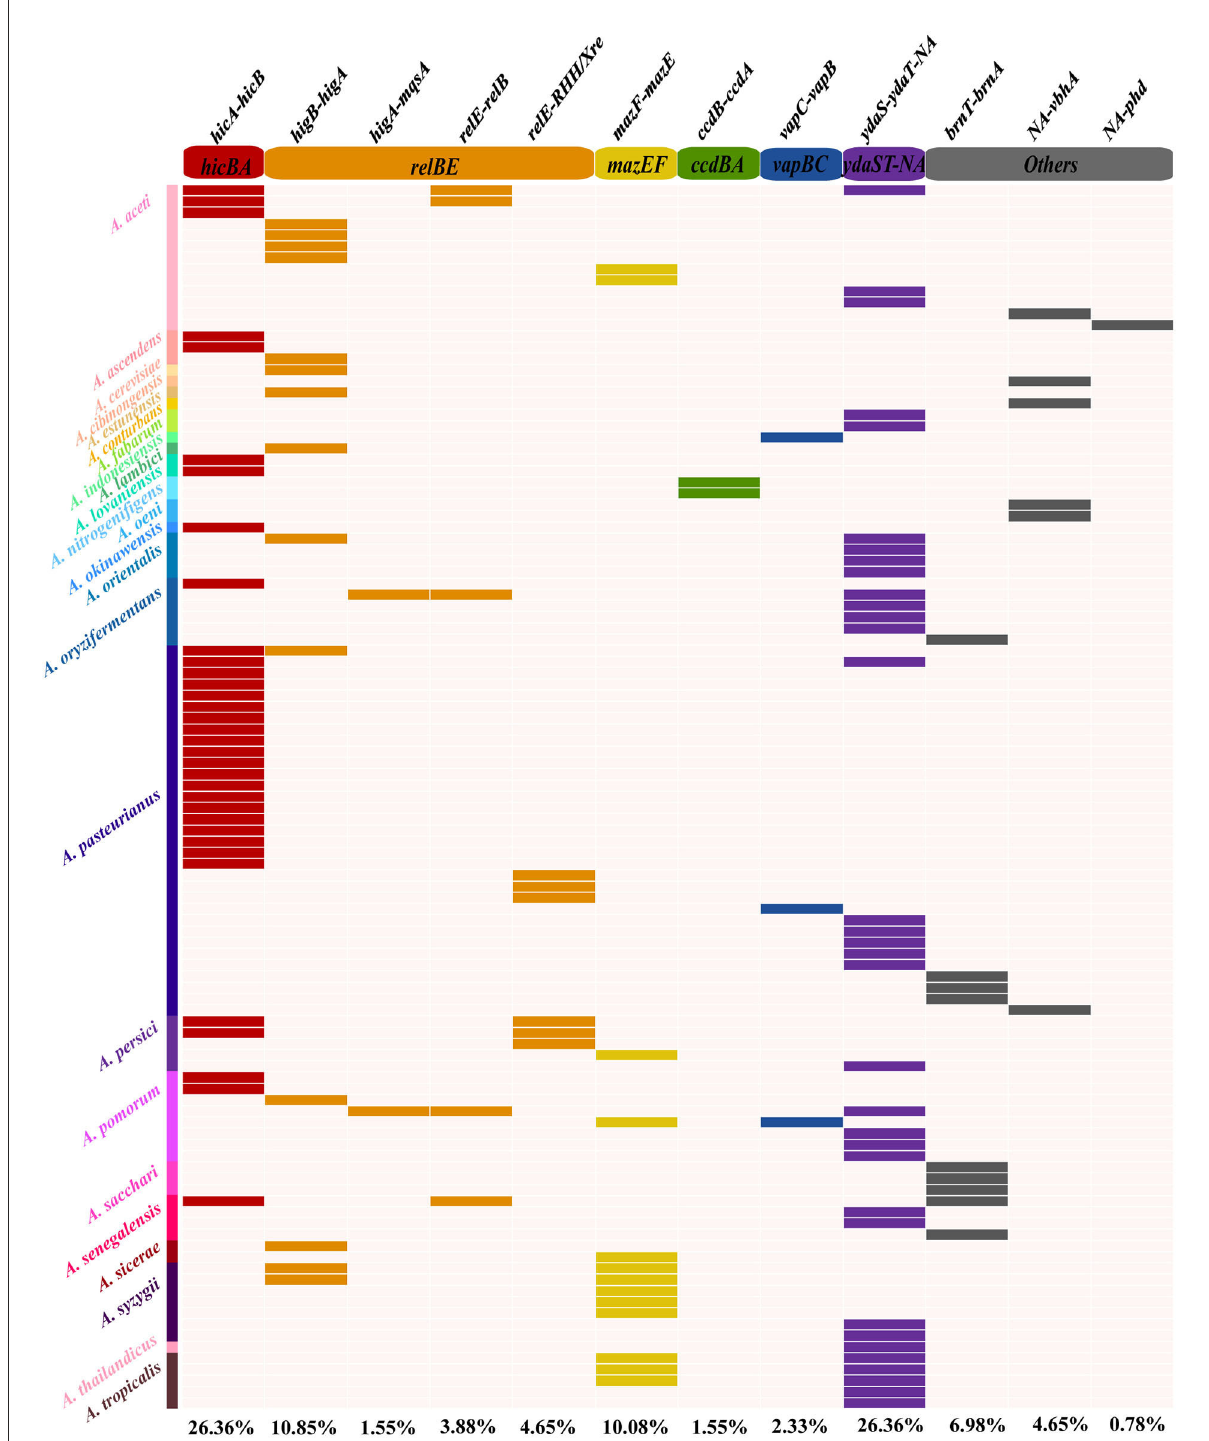
FIGURE4 Distribution of type II TAs in Acetobacter prophages. Gene names and the corresponding type II TA families are displayed on the top of the heat map. Different colors on the left side represent different Acetobacter